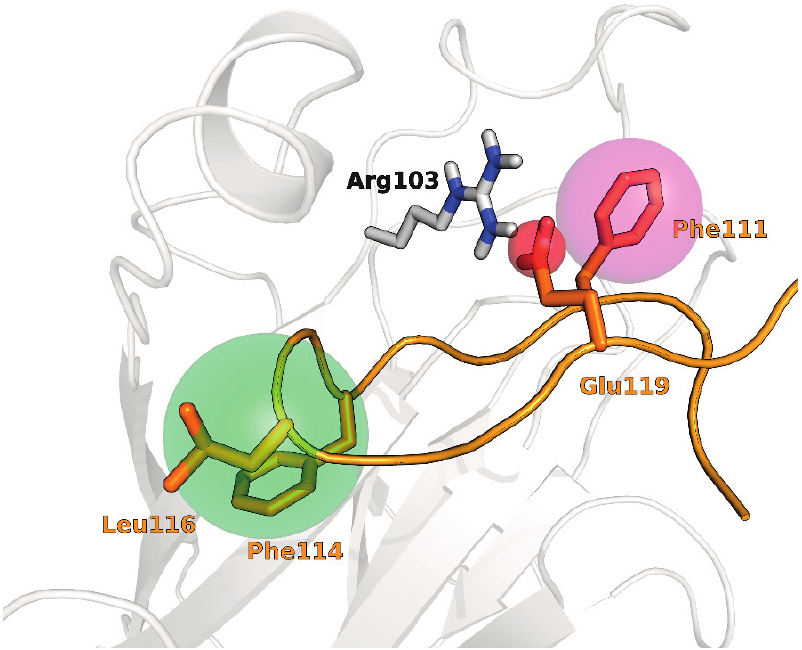
Figure 9. Constraints employed during knowledge-based docking runs . Constraints sites (hydrophobic, green; negatively charged, red; aromatic, magenta) are represented as spheres on the G-H loop of ephrin-A1 in complex with EphA2.